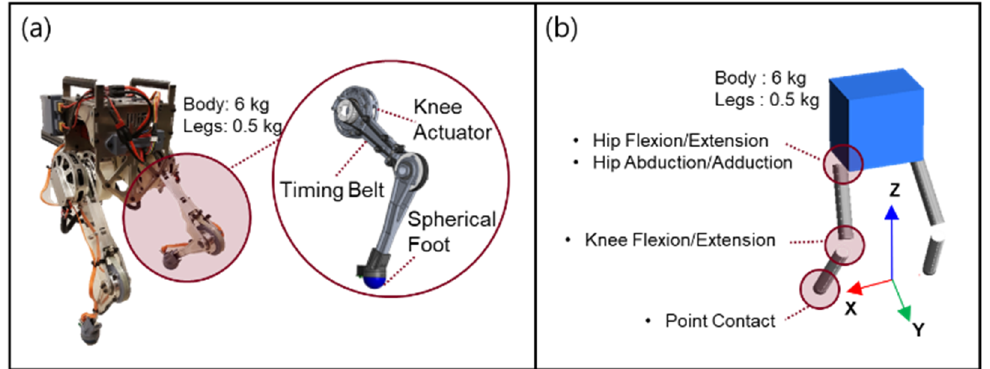
Figure 3. Bipedal robot platform used to acquire the human-operated balancing data and evaluate the performance of the developed balance control system: ( a ) Actual robot, Little HERMES. ( b ) Multi-body dynamics model of Little HERMES programmed via physics engine, MuJoCo.